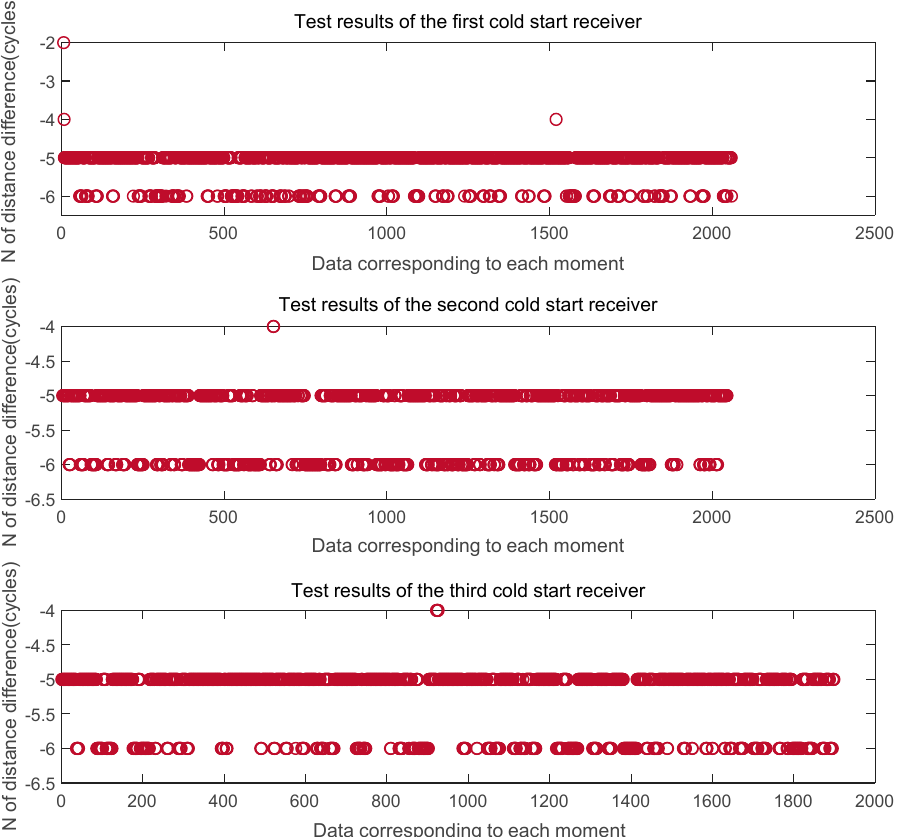
Figure 9. The distance based on the phase di ff erence is estimated by the whole number of wavelengths.